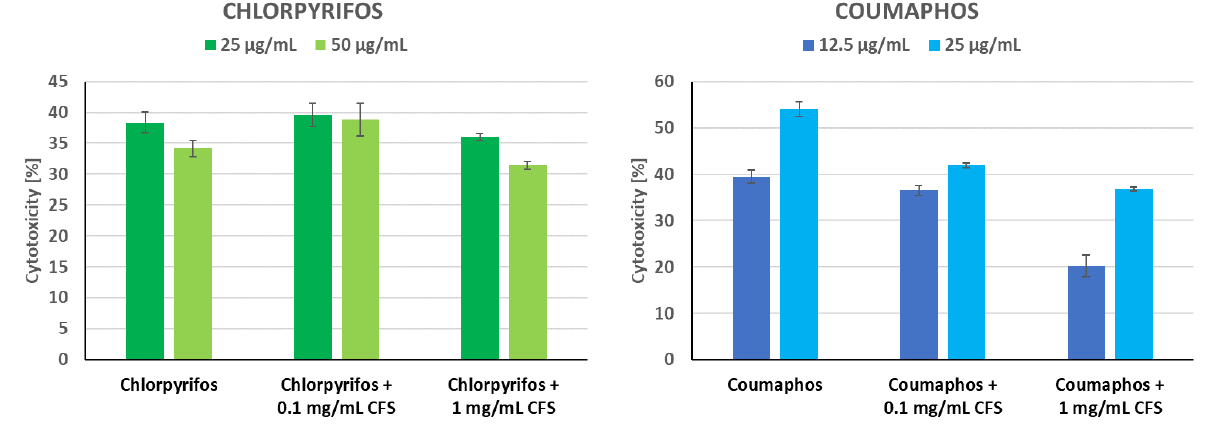
Figure 5. The ability of P. pentosaceus 14/1 cell-free supernatant to protect Caco-2 cells against the cytotoxicity of insecticides. Firstly cells were exposed to cell-free supernatant at IC 0 (24 h, un- published data) and then to selected insecticide at concentration ≤ IC 50 (24 h). Results are presented as mean ± standard